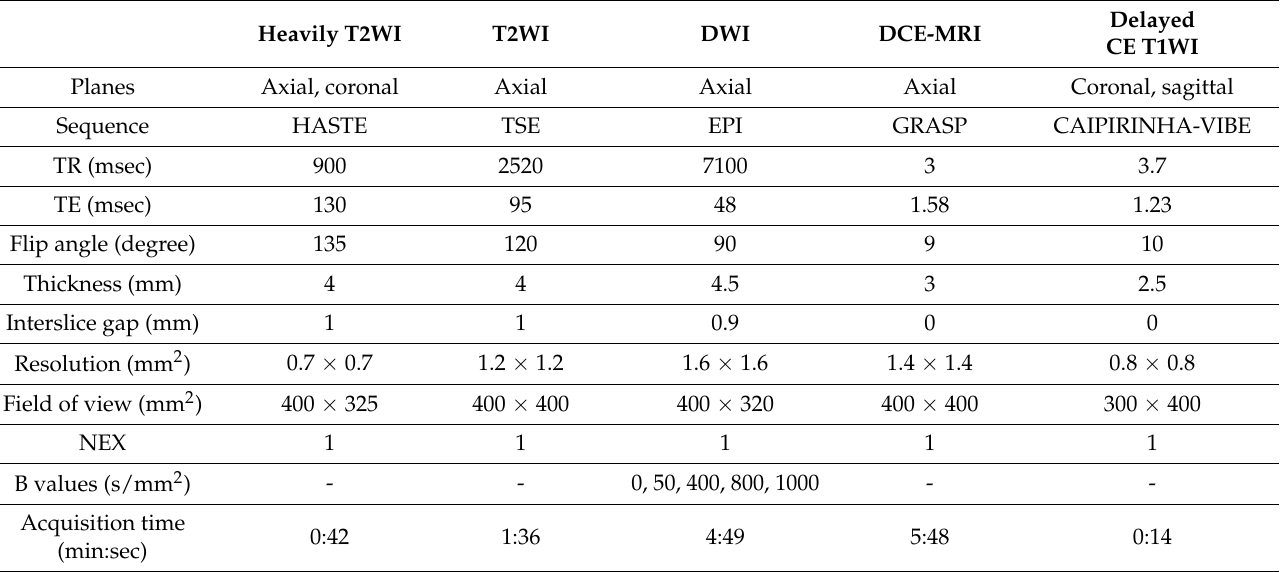
Table 1. MRI sequences and